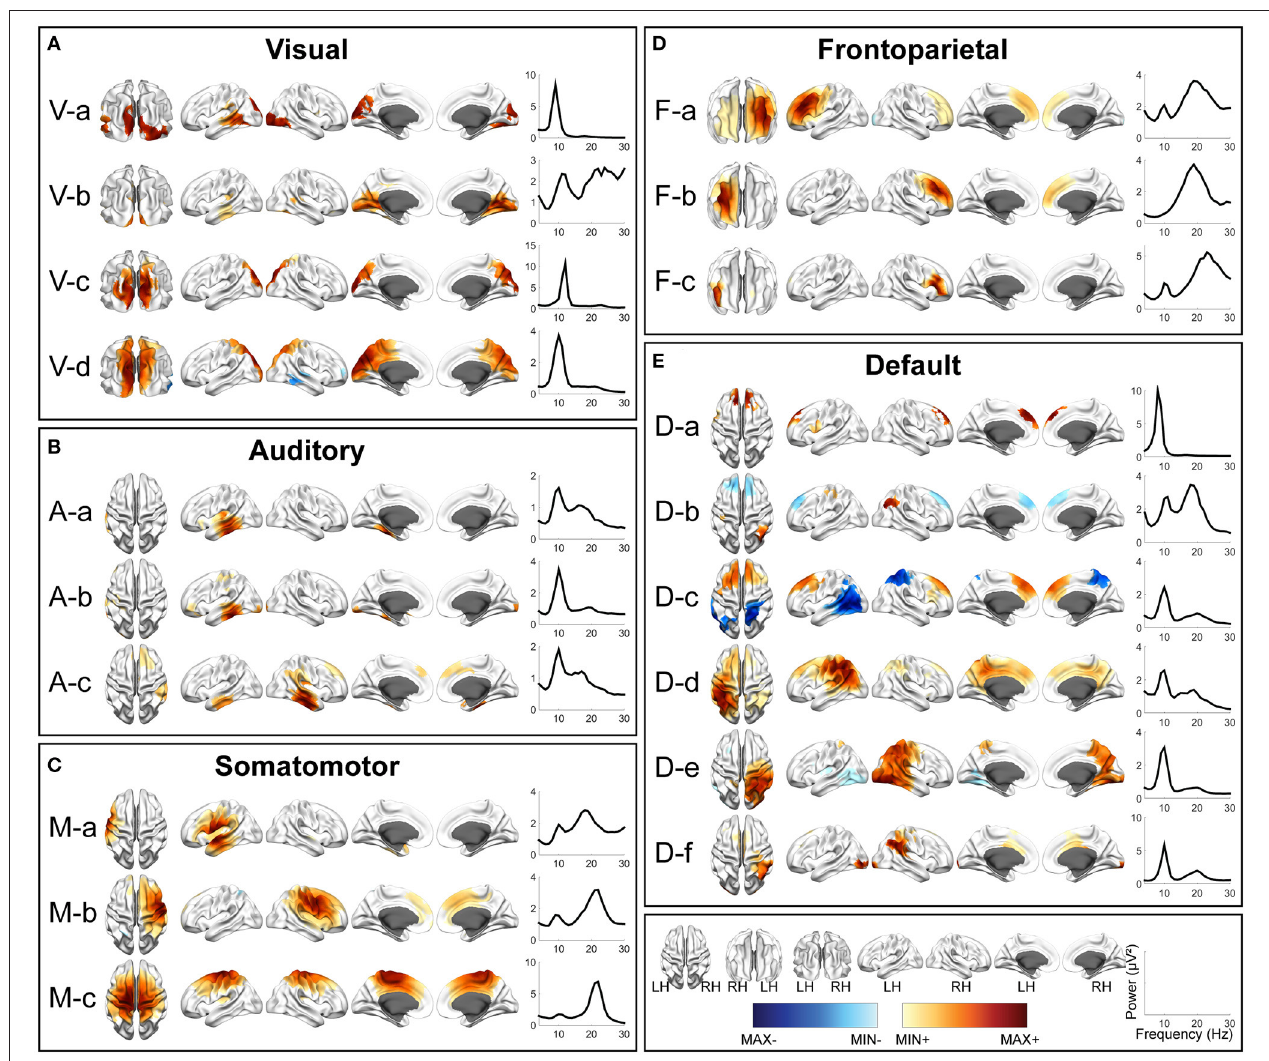
FIGURE 4 | Spatial and spectral patterns of five RSN classes from TFICA-SCT on the Pre-/Post-rTMS EEG data. (A) Visual, (B) auditory, (C) somatomotor, (D) frontoparietal, and (E) default mode networks. Group-level SCT maps were thresholded at p < 0.01, cluster-based